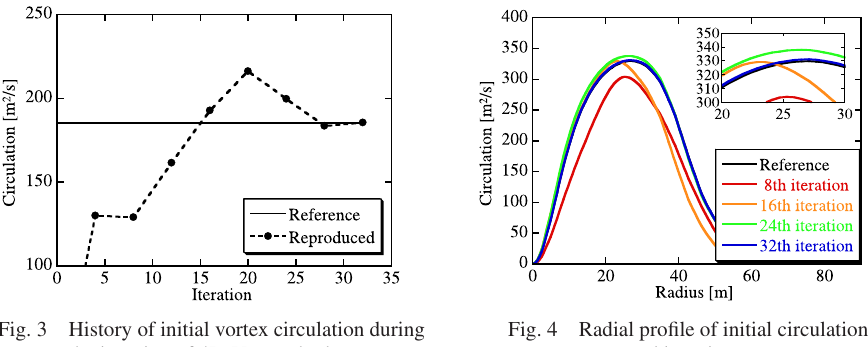
Fig. 4 Radial profile of initial circulation at several iteration